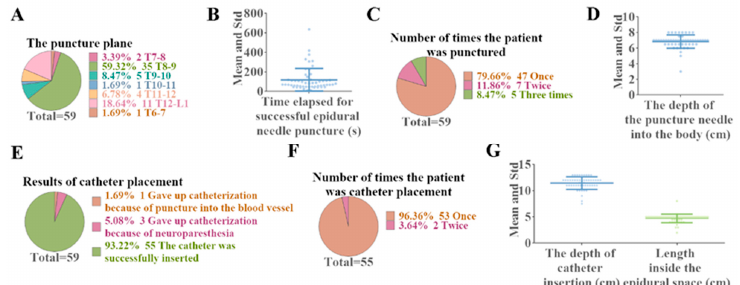
Figure 5. Outcomes of ultrasound-guided epidural catheterization in the absence of specific pos- tures. Of the 60 cases observed, only one patient abandoned epidural puncture due to poor ultra- sound imaging results. Among the 59 patients with successful puncture, the patients with puncture plane at T8-9 accounted for the largest proportion ( A : Puncture plane distribution of successful epi- dural puncture), and the average time was 119.37 s ( B : Duration of epidural puncture). The majority of patients completed the epidural catheterization procedure successfully the first time ( C : Number of epidural punctures performed by the patient), and the average depth of puncture needle place- ment was 6.83 cm ( D : The depth of the epidural puncture needle (cm)). Of the patients with suc- cessful puncture, 55 completed epidural catheterization ( E : Results of catheter placement), of whom 96.36% completed the catheterization on the first attempt ( F ). The mean depth of catheter placement ( G , Left) and the mean depth in the epidural space ( G , Right) were 11.41 cm and 4.72 cm, respec- tively. Abbreviation: % = percentage, T = Thoracic vertebra, L = lumbar vertebra, Std = Standard deviation, s = second(s); cm =